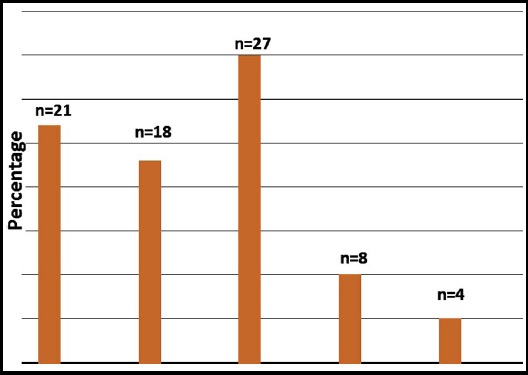
Estimated glomerular filtration rate in 78 children with Severe Acute Malnutrition.